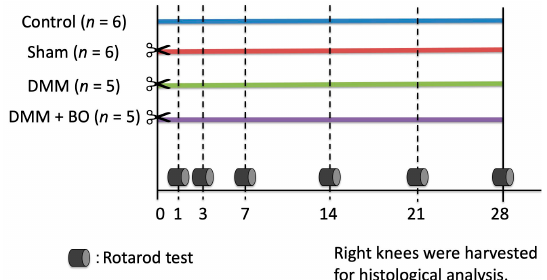
Figure 1. Experimental protocol of the present study. Destabilization of the medial meniscus (DMM) and the sham surgery were performed on the right knee on day 0 ( ✂ ). Boiogito (BO) was mixed in the chow at a concentration of 3%. The rotarod test was performed prior to and 1, 3, 7, 14, 21, and 28 days after the DMM surgery. The rats were sacrificed, and their right knees were harvested for histological analysis on day 28.